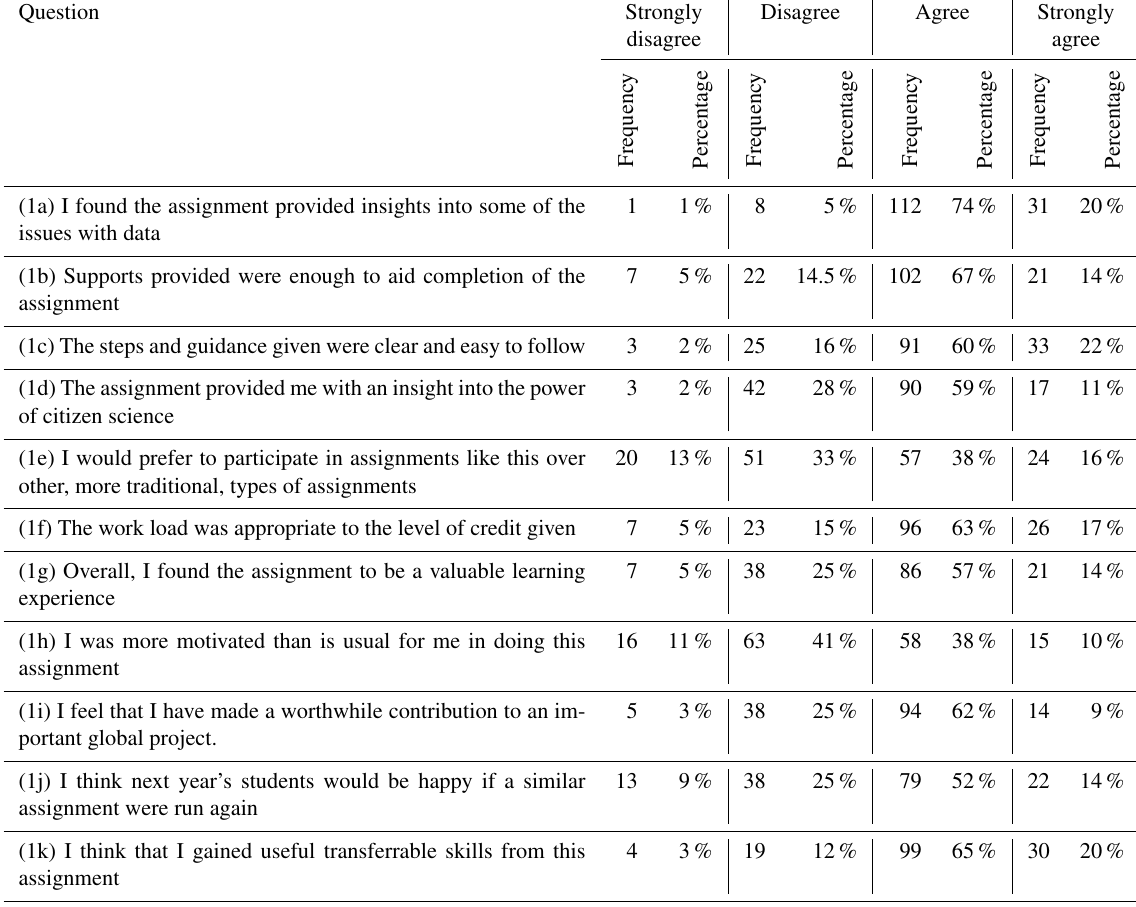
Table 1. Results of the survey questions (1a–1k) that asked the students to indicate the extent to which they agree or disagree with specific statements. The frequency of responses and the percentage of the total responses to each question are presented (152 students participated in the